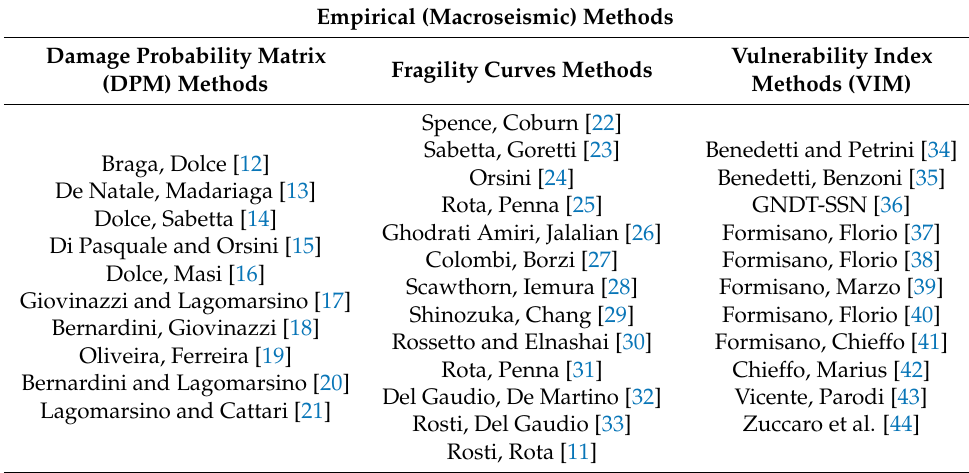
Table 1. Summary of different proposals for the empirical analysis of masonry